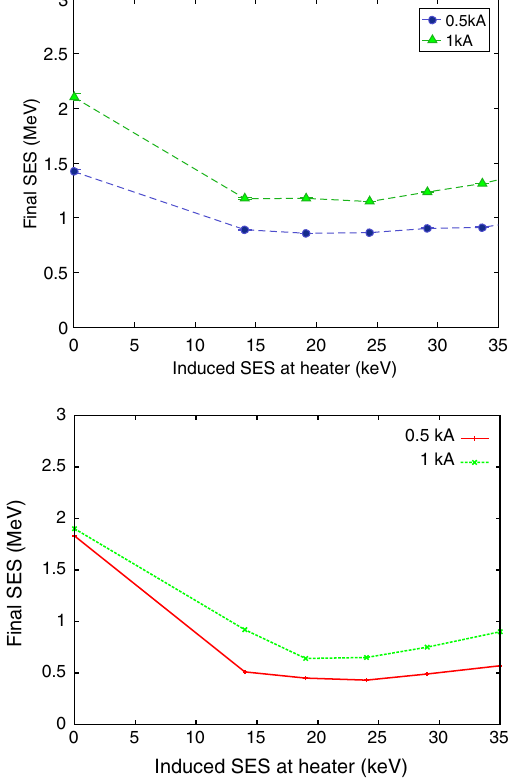
FIG. 13. Final slice rms energy spread after the undulator as a function of laser heater induced extra energy spread. The top plot is the measurement from Ref. [17], while the bottom is from simulation.